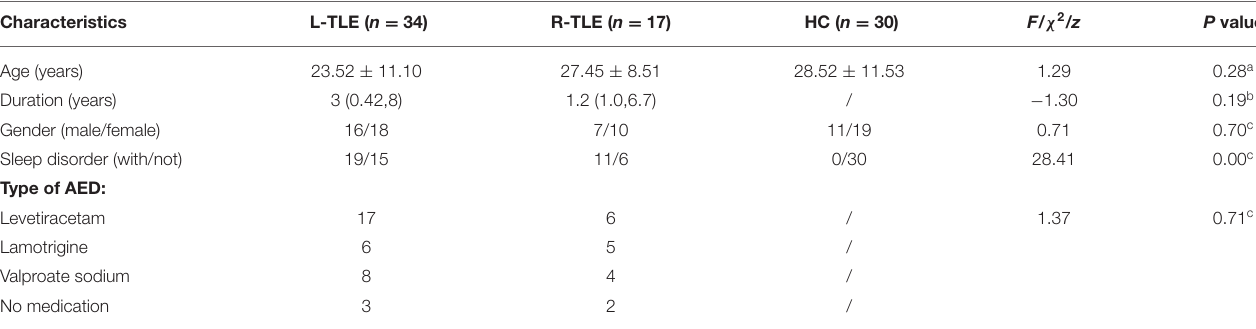
TABLE 1 | The demographic and clinical characteristics in subjects of the study.